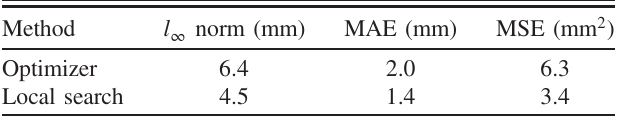
TABLE II. Maximum absolute error ( l ∞ norm), MAE, and MSE of the best individual of the optimizer and local search compared to the measurement. In both cases, the maximum error is at turn 2.